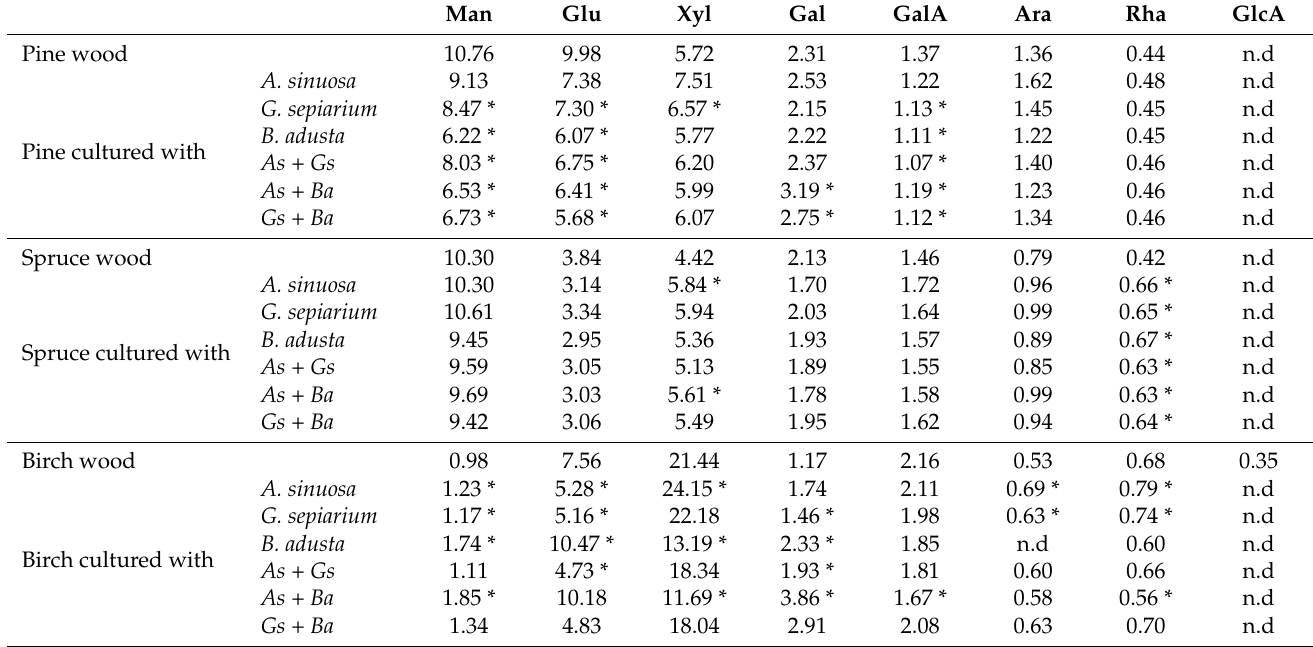
Table 1. Hemicellulose- and pectin-derived monosaccharide composition (g/100 g wood (%)) after fungal cultivations, measured by acid methanolysis. As + Gs = A. sinuosa and G. sepiarium , As + Ba = A. sinuosa and B. adusta , Gs + Ba = G. sepiarium and B. adusta